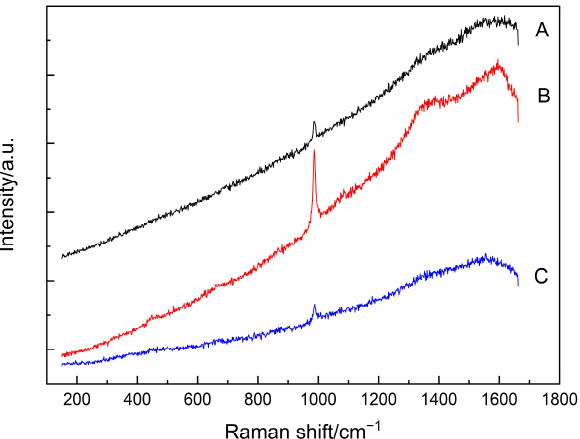
Figure 8. Raman spectra of the analyzed points (A–C) as shown in Figure 7.